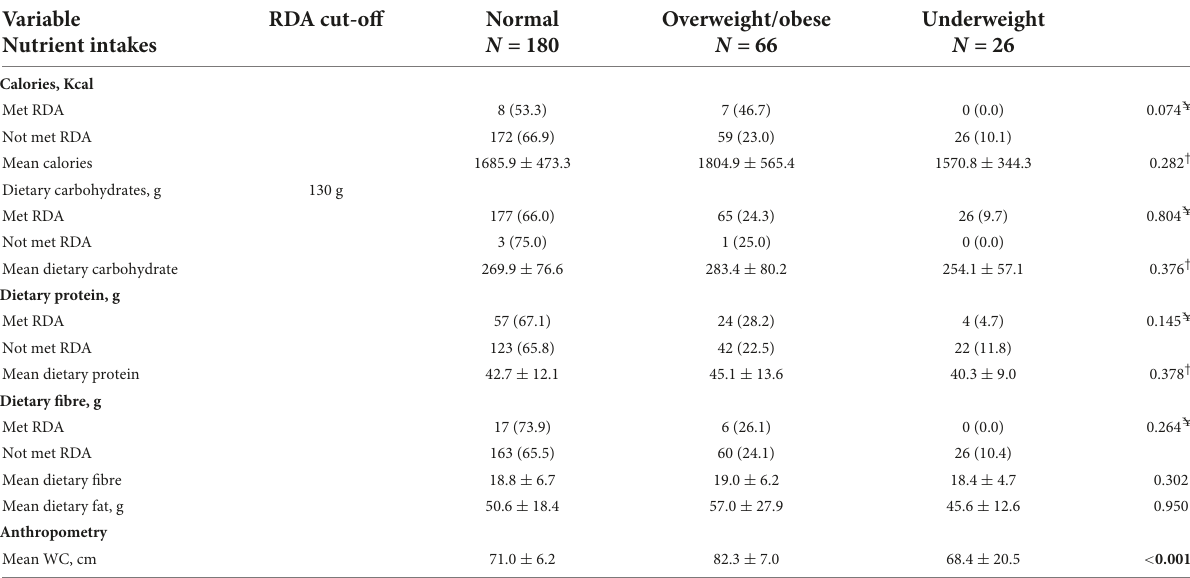
TABLE 4 Calories, macronutrient intakes, and body mass index status.